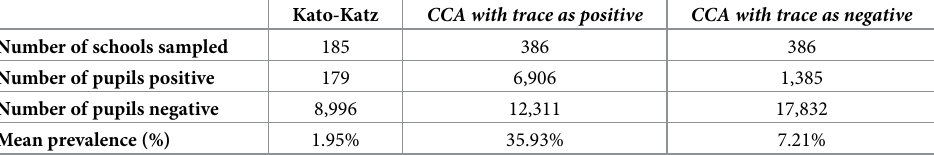
Table 1. Summary statistics of observed Schistosoma mansoni prevalence across Rwandan schools recorded using different diagnostic methods. A total of 5,547 CCA results were categorised as ‘trace’. The CCA with trace as positive dataset considered these as positive, while the CCA with trace as negative dataset considered these as negative. CCA; Circulating Cathodic